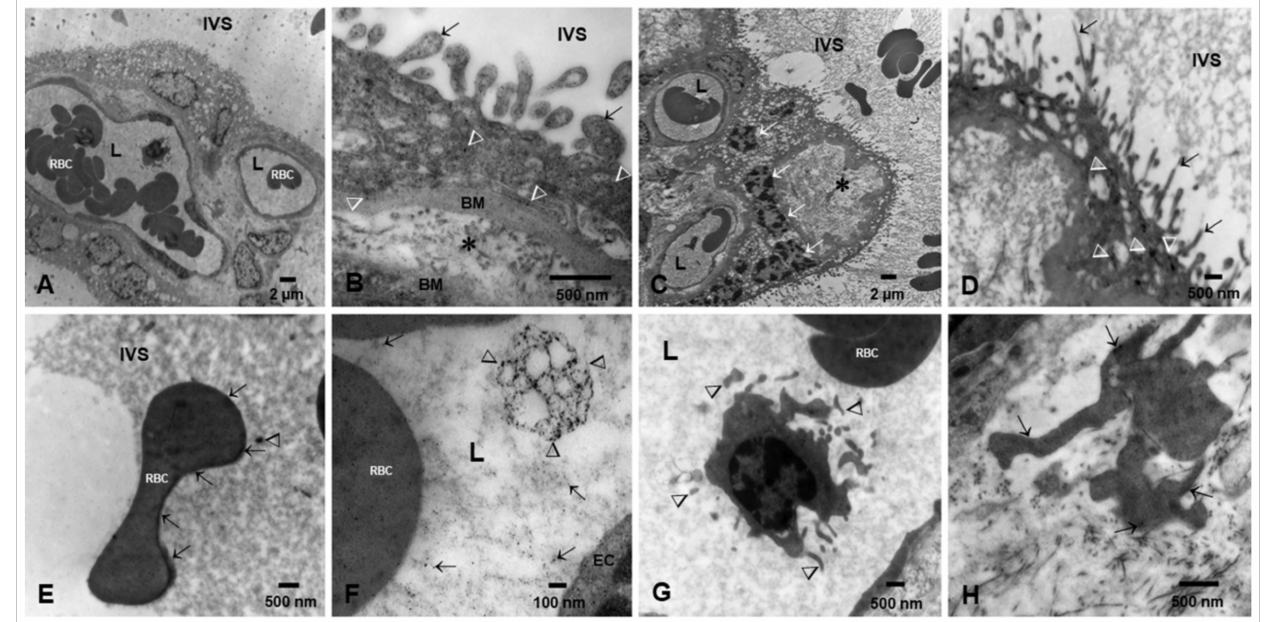
Figure 3. Preeclamptic placentas TEM. ( A ). Villous cores with vacuolated syncytiotrophoblast and few fetal blood vessels lumen (L) containing fetal RBC and white blood cells (WBC). The maternal IVS can be seen. ( B ). A close-up of a villous section with numerous NPs (arrow heads) throughout the layer and also in the prolongations into the IVS (short arrows). The cytotrophoblast basement membrane is irregularly thick (BM), also contain NPs, and is separated from the EC basement membrane by abundant collagen tissue (*). ( C , D ) are examples of severe preeclamptic cases with thin syncytiotrophoblast and numerous clusters of pyknotic nuclei (white arrows) in the midst of vacuolated areas (*). Fetal blood vessels are few, ECs are flat and thin, and the lumen (L) is occupied by RBC. ( D ) shows a close-up of a syncytiotrophoblast with thin extensions (short arrows) into the IVS and numerous NPs with elongated shapes (arrow heads). ( E ). This is a maternal RBC in the IVS showing abundant NPs lining the surface of the cell. Free NPs are also observed (arrowhead). ( F ). Close-up of a fetal blood vessel lumen (L) and EC showing a ~600 nm irregular exosome decorated with numerous NPs (arrowheads); also notice the free lumen NPs (short arrows). ( G ). In the same fetal blood vessel as ( A ), a monocytic WBC is seen at high power with its branched projections (short arrows). In the midst of the collagenous fibers, fibroblastic cell processes display numerous NPs (short arrows) ( H